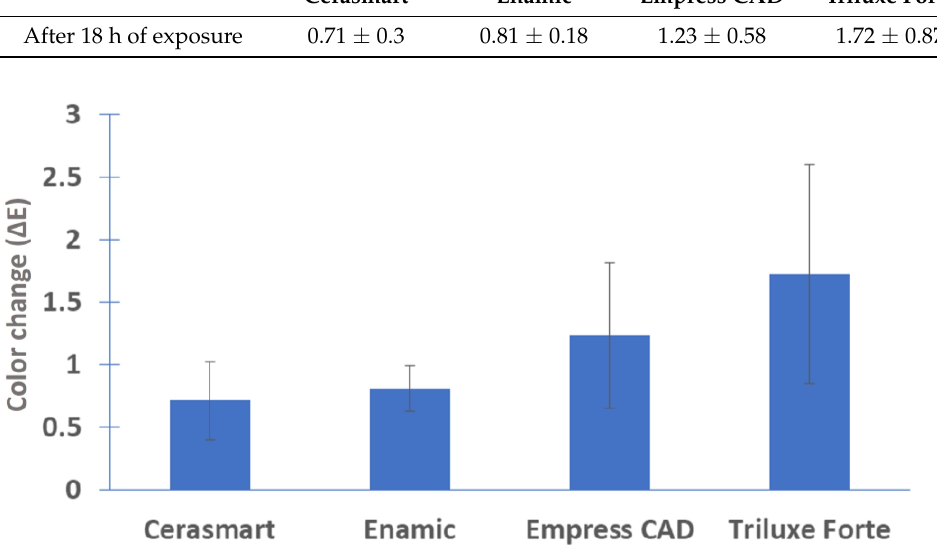
Figure 1. Comparison between the four CAD-CAM monolithic materials, after 18 h of simulated gastric acid solution exposure. gastric acid solution exposure.